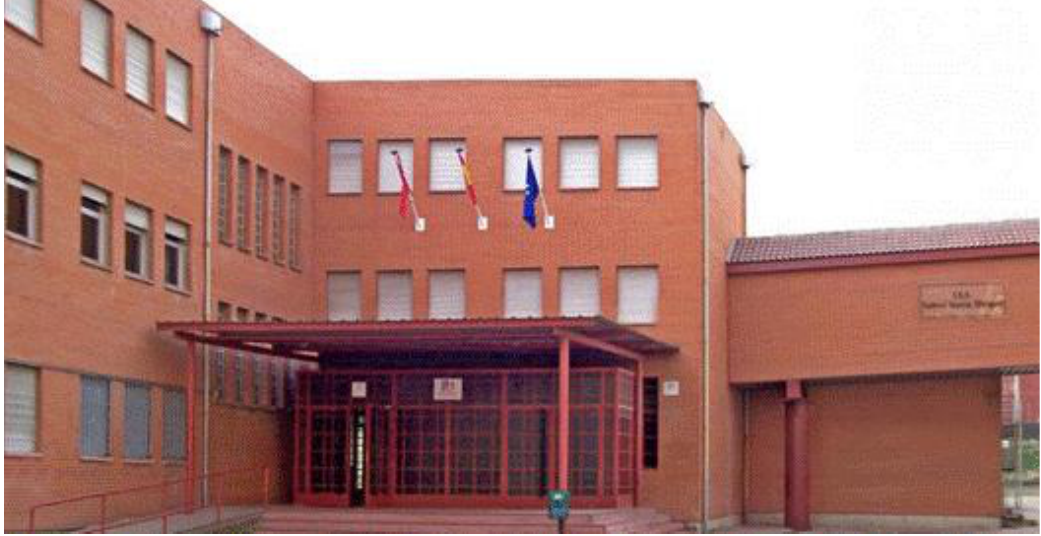
Figure 1. IES Gabriel García Márquez public high school.